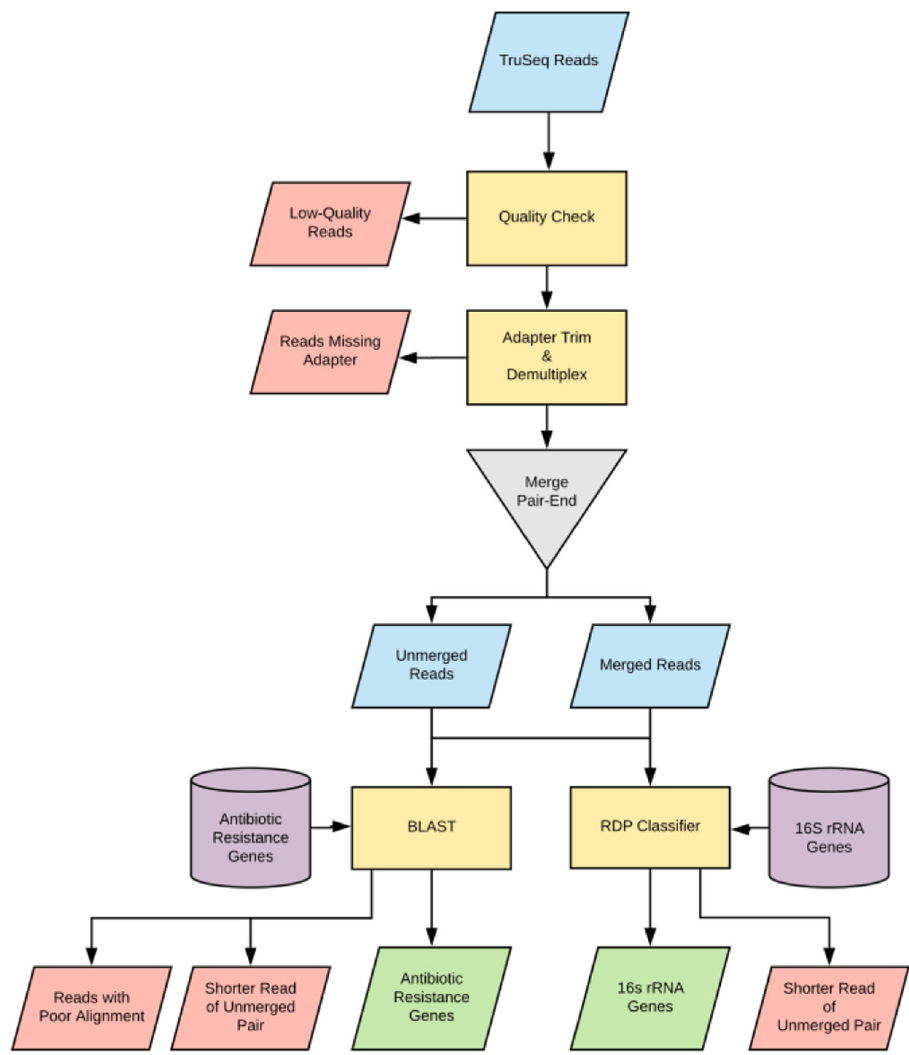
Fig. 1 DARTE-QM bioinformatic pipeline. Boxes colored blue represent reads retained through the pipeline, red were discarded, and green are the fi nalized reads ready for analysis. Reads were fi ltered by quality score and demultiplexed by the presence of primer sequences. To classify ARGs, both merged and unmerged reads were required to align to known genes in ResFam and CARD ARG reference databases. In the case of unmerged reads, if both the forward and the reverse read aligned to the same target, the shorter alignment from the pair was